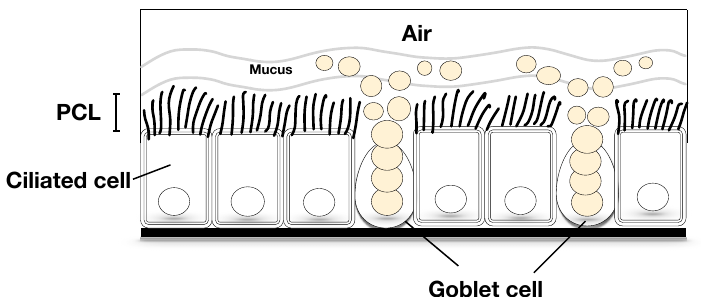
Figure 1. Patchwork of muco-ciliary clearance in the respiratory